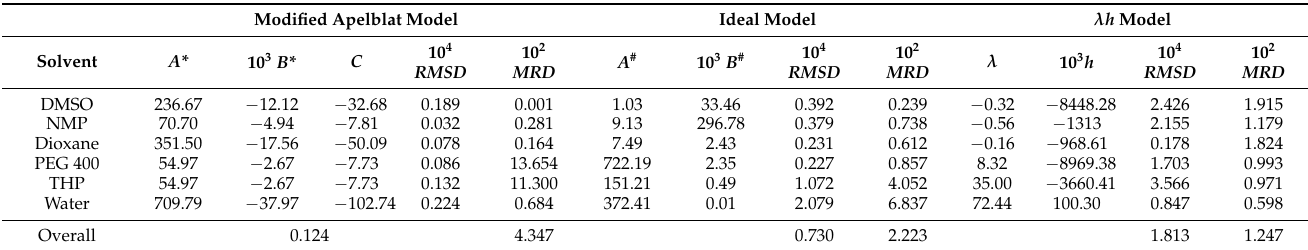
Table 4. Parameters of the modified Apelblat equation, Ideal equation, and λ h equation for GLN in organic